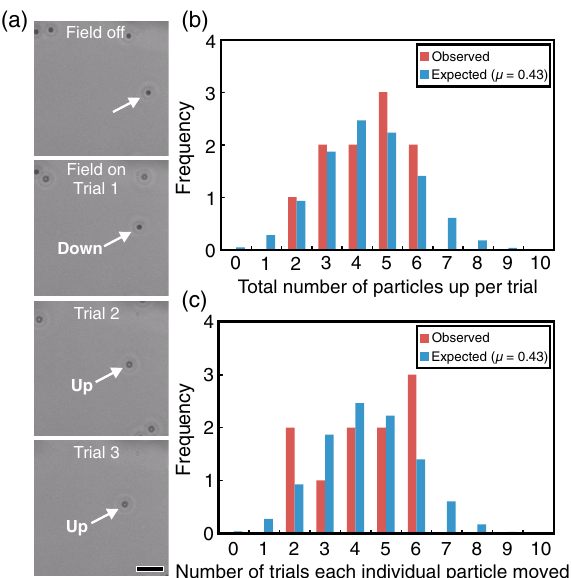
FIG. 3. Binomial statistics for the 10 bifurcation trials repre- sented in Table I. Statistics were acquired for 2 μ m sulfated polystyrene suspended in 1 mM NaOH with an applied potential of 5 Vpp, 100 Hz. (a) Representative images of particle bifurcation trials in the optical microscope. The white arrows follow the same particle (particle 9 in Table I) through each bifurcation trial, indicating whether the particle moved up or down when the potential was applied. (b) Histogram of the total number of particles that moved up per trial. (c) Histogram of the number of trials where an individual particle moved up. Both histograms are compared to a binomial distribution with an expected probability of success of μ ¼ 0 . 43 , which is the average probability for the particles to move up over 10 trials.